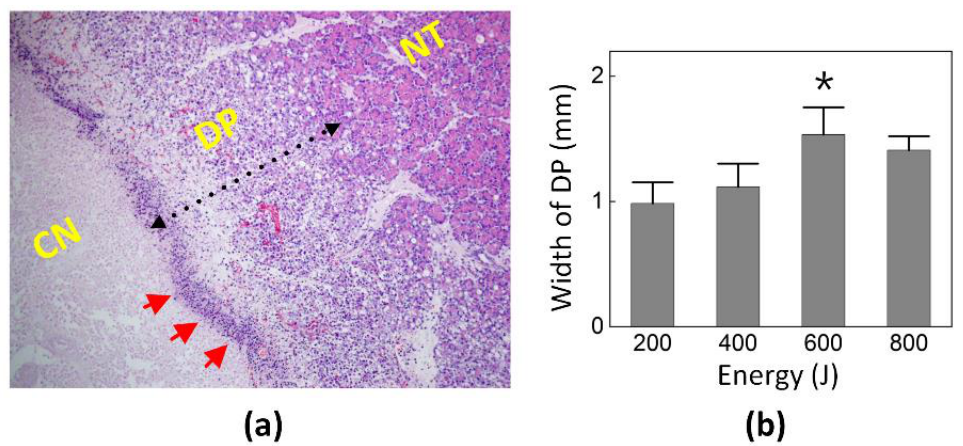
Figure 5. Histological assessments of parenchymatous degeneration in pancreatic tissue after EUS- guide LA: ( a ) Hematoxylin and eosin (HE)-stained histology image (100 × ) showing boundary between native tissue (NT) and coagulation necrosis (CN) and ( b ) quantitative comparison of width of degenerative parenchyma (DP) in four energy groups. Red arrows indicate an inflammatory band (* MU p < 0.05 vs. 200 J and 400 J).